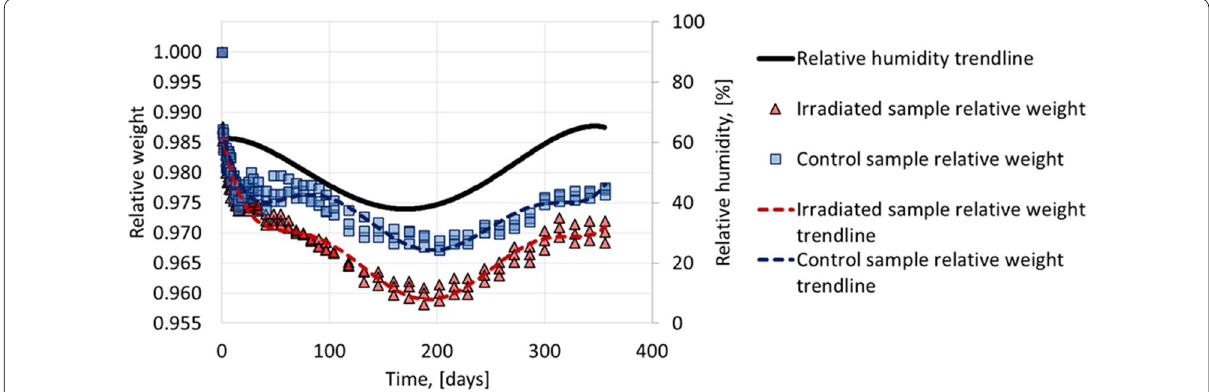
Fig. 7 Change in relative